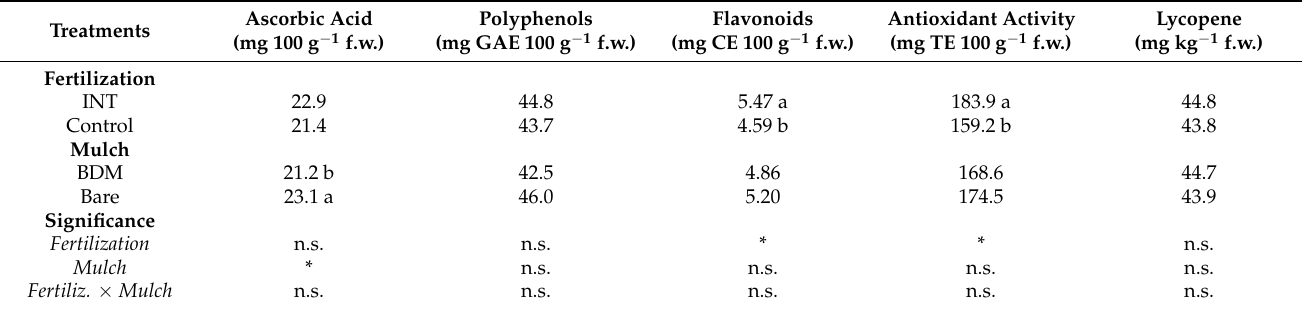
Table 9. Antioxidant compounds and antioxidant activity of tomato fruits cv Kendras, in 2018, as influenced by the mean effects of fertilization, mulch, and their interaction. Ascorbic Acid Polyphenols Flavonoids Antioxidant Activity Lycopene Treatments (mg 100 g − 1 f.w.) (mg GAE 100 g − 1 f.w.) (mg CE 100 g − 1 f.w.) (mg TE 100 g − 1 f.w.) (mg kg − 1